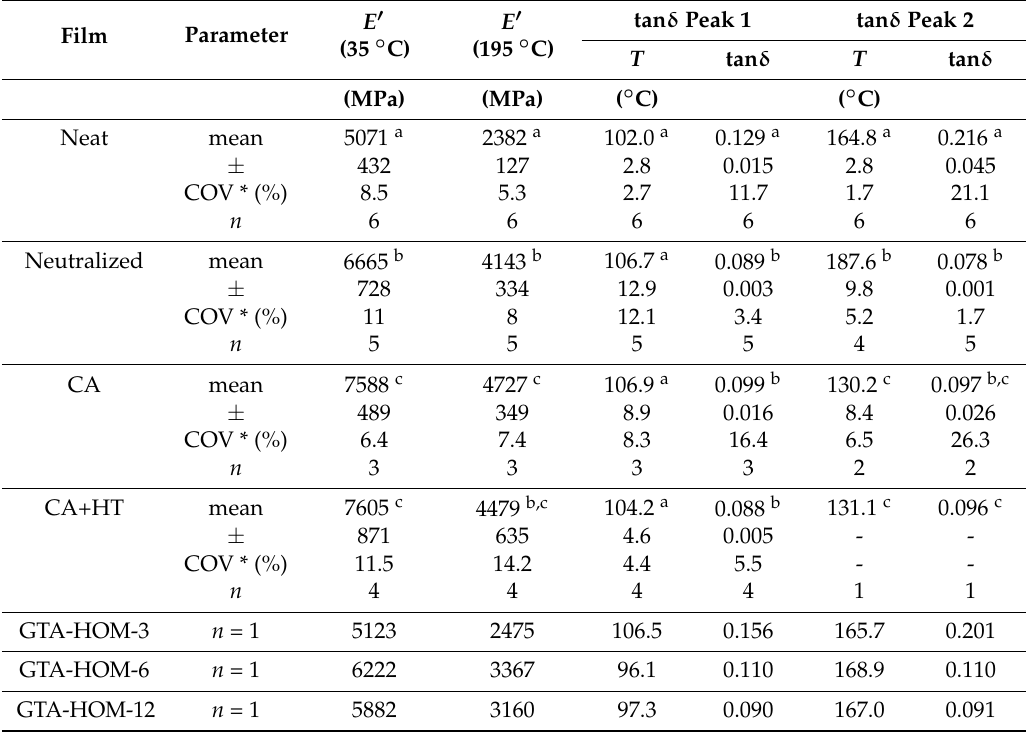
Table 3. Characteristics of the dynamic mechanical analysis (DMA) curves for film specimens with no-preheating (see Table 2 for film code